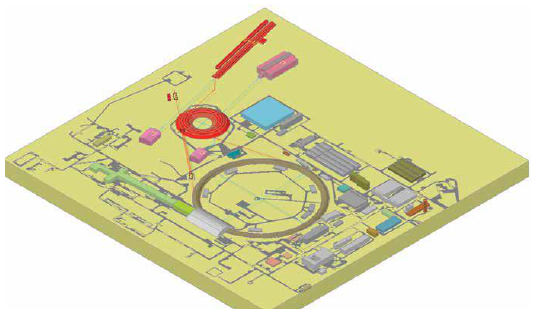
Figure 2 (from ref. [10]). Location of the Facility for Intense Hadron Beams: 1 – Linear accelerator LU-400 (red color); 2 – Rapid cycling synchrotron U-3.5 (red